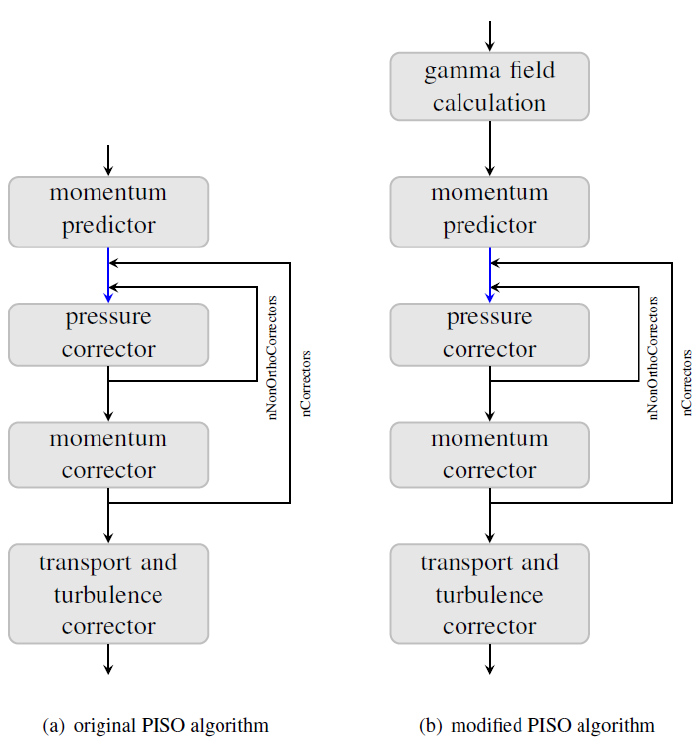
Figure 3. Pressure Implicit with Splitting of Operator (PISO) algorithm before and after the adjust-